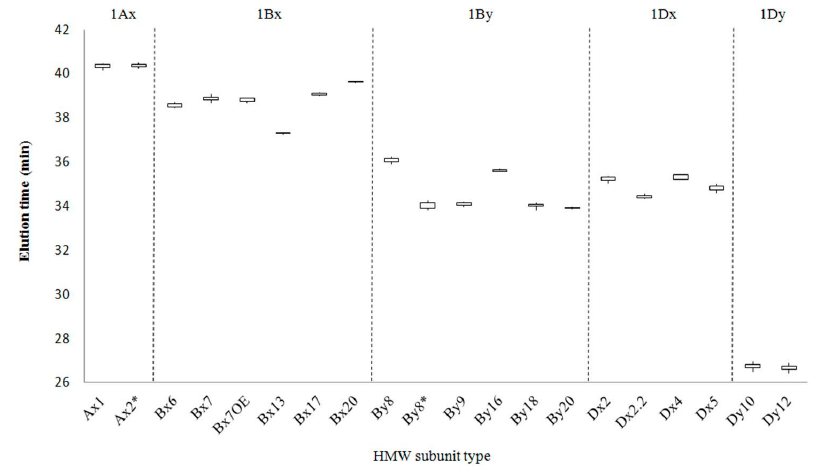
Figure 3. Box and whisker plot of retention times of standard wheat cultivars.